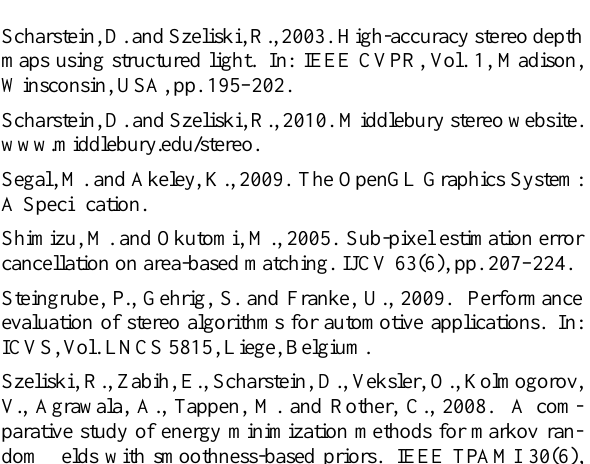
Figure 7: Left and right rectified aerial image with 142 MPixel, disparity image by eSGM and corresponding confidence